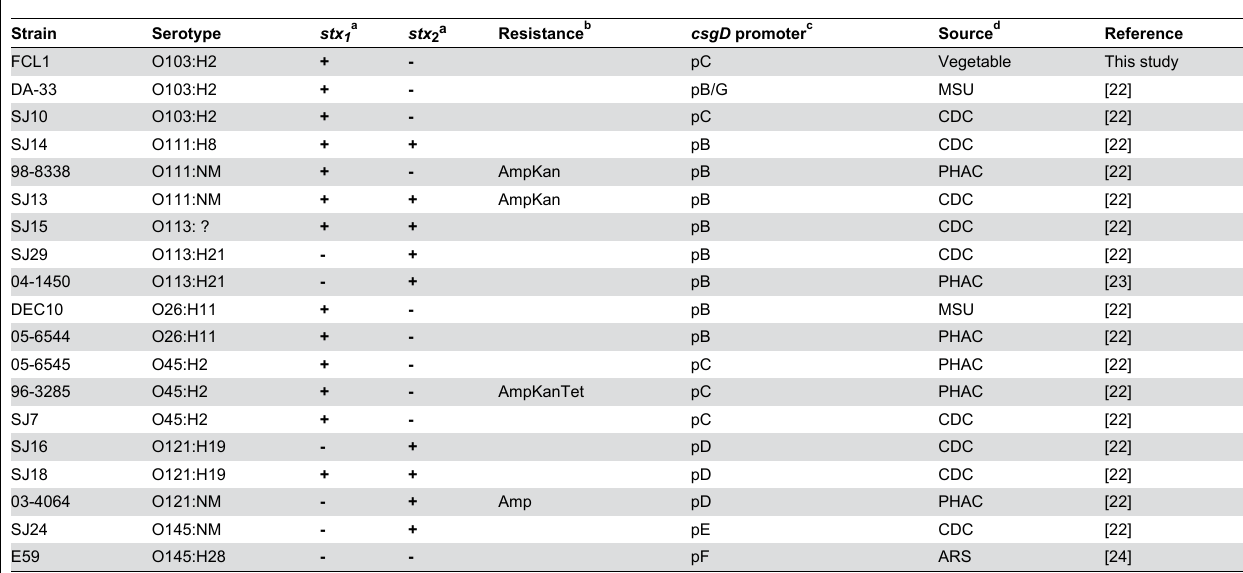
Table 1. List of the STEC strains used in this